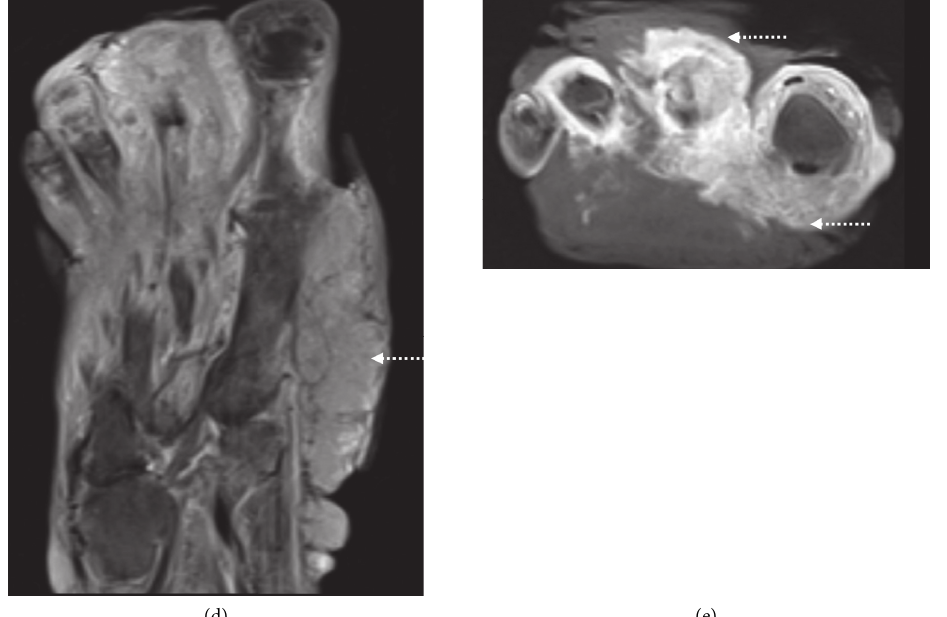
Figure 10: Metastases. Axial T1 (a) pelvis at the level of the hip joint of a 47-year-old female with metastatic breast cancer involving the right acetabulum. Ill-defined acetabular cortex is consistent with cortical breach of tumour and intraarticular extension (arrow). Tumour exhibits mass-effect that is usually readily apparent on MRI. Tumour is usually hyperintense in fluid-sensitive sequences which can mimic infection. Coronal PDFS (b) at the anterior acetabular margin with fluid-hyperintensity of the tumour breaching the acetabular cortex (arrow). Periosteal extension lateral pelvis (dotted arrow). A separate metastatic deposit also presents in the proximal right femoral shaft which helps clinch the diagnosis (dash). Axial T1 (c) and coronal STIR (d) and axial fat-saturated postcontrast T1 (e) of the right foot of a 38-year-old man with AIDS-related Kaposi sarcoma. The fungating, partially necrotic/enhancing mass (e) is centred in the forefoot, particularly involving the second metatarsal (arrow). The signal intensity of the involved bone mimics that of osteomyelitis, although infection should not be infiltrative and mass-forming (dotted